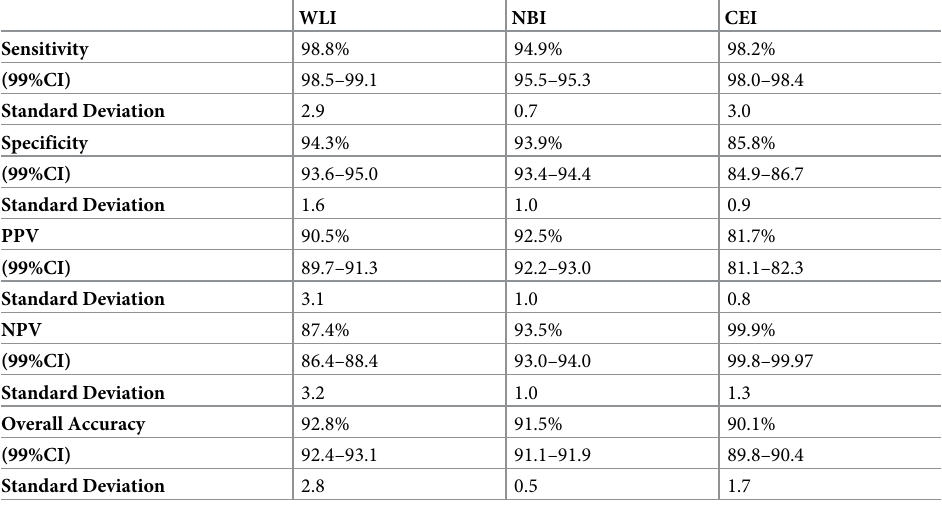
Table 4. Diagnostic performance for the adenomatous polyps in the ResNet